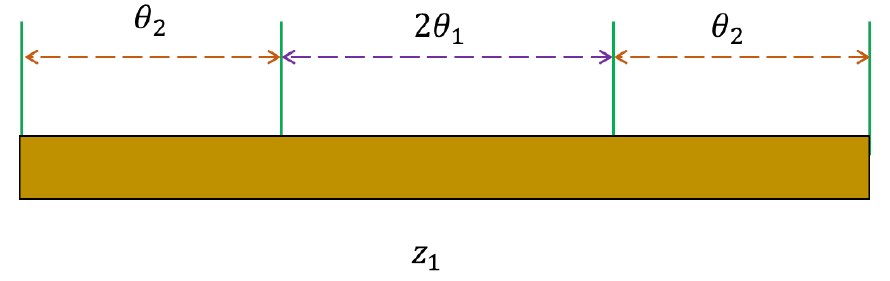
Figure 2. SIR varieties: ( a ) quarter-wavelength type; ( b ) half-wavelength type.